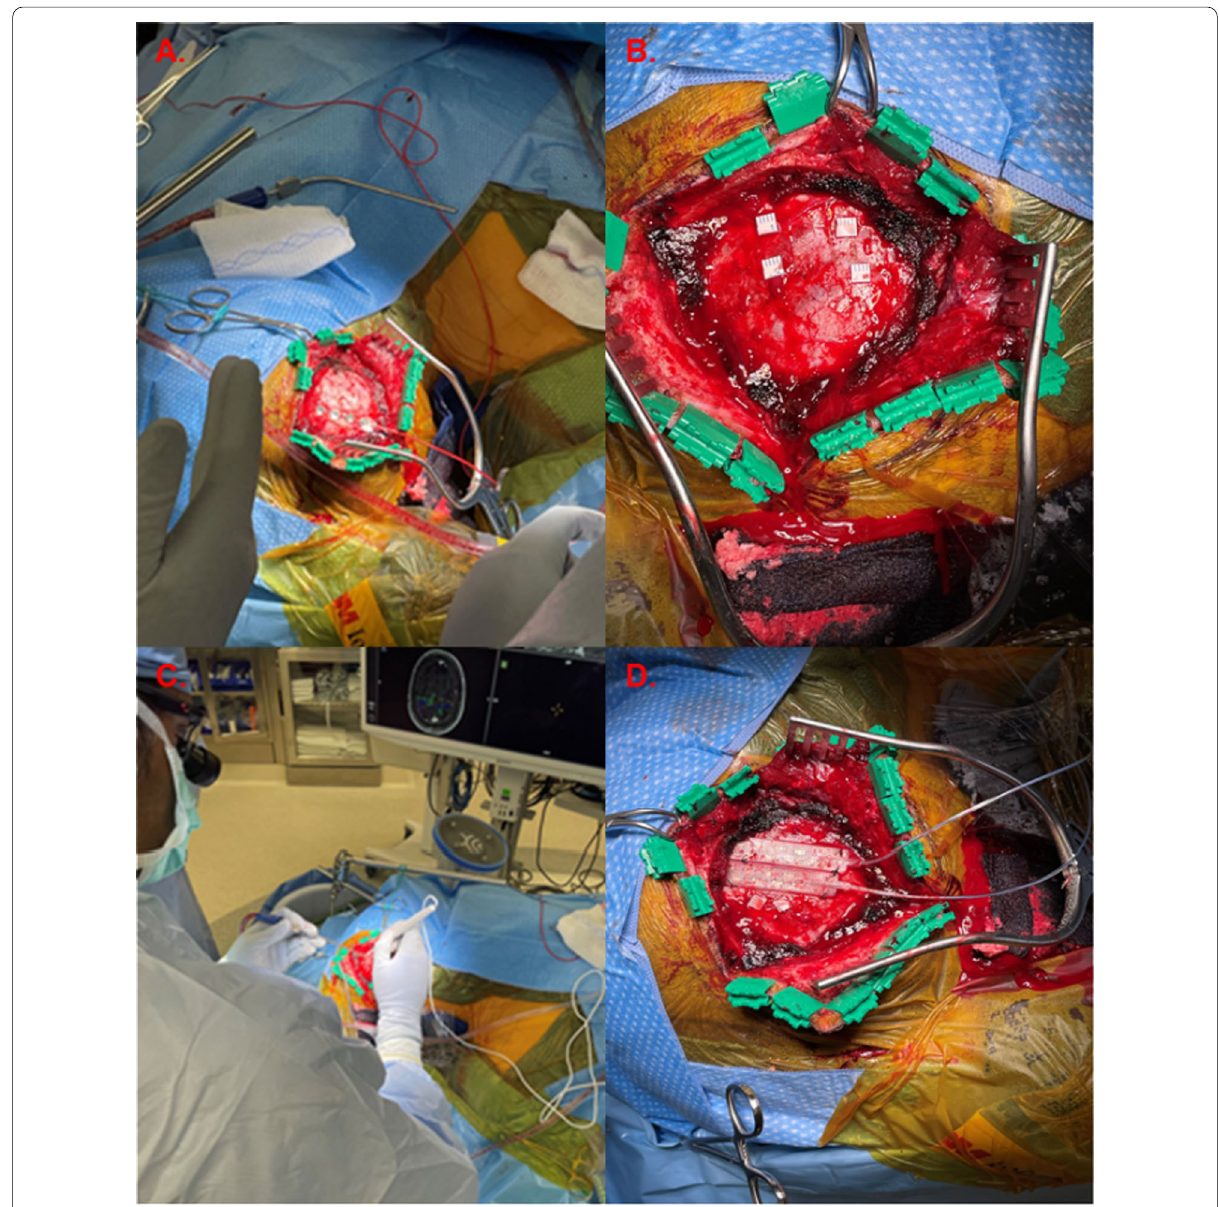
Fig. 2 Intraoperative imaging: A epidural phase reversal; B epidural markers of facial and hand motor cortex as identified by intraoperative DTI/ fMRI; C cortical stimulation with EMG/muscle activity proxy; D final positioning of epidural